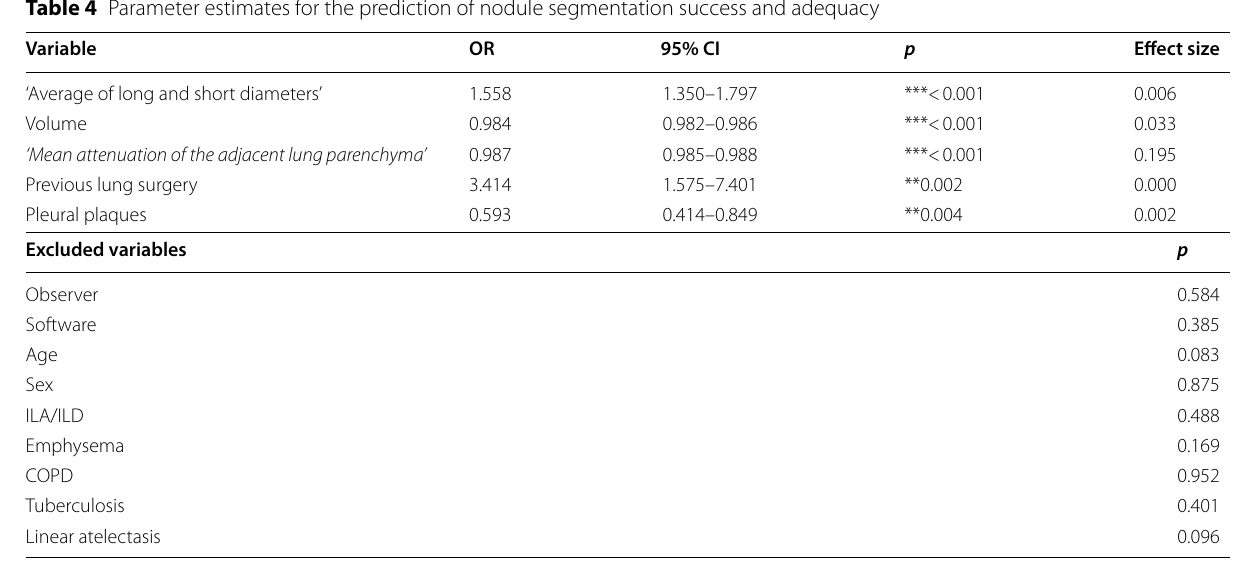
OR, odds ratio; CI, confidence interval; *** p < 0.001; ** p < 0.01 ILA, interstitial lung abnormality; ILD, interstitial lung disease; COPD, chronic obstructive pulmonary